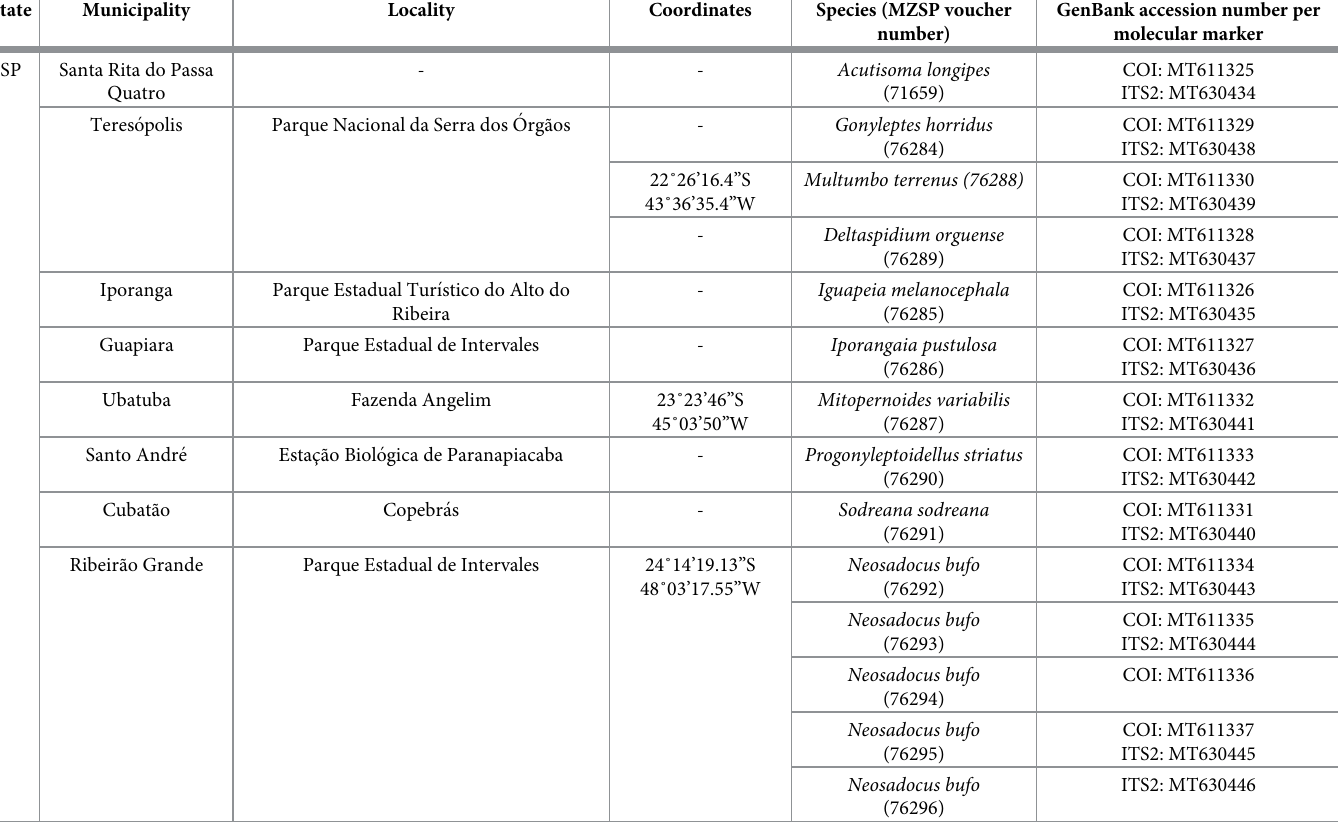
Table 1. Geographic information, MZSP voucher numbers and GenBank accession numbers of the outgroup species and Neosadocus specimens used in this